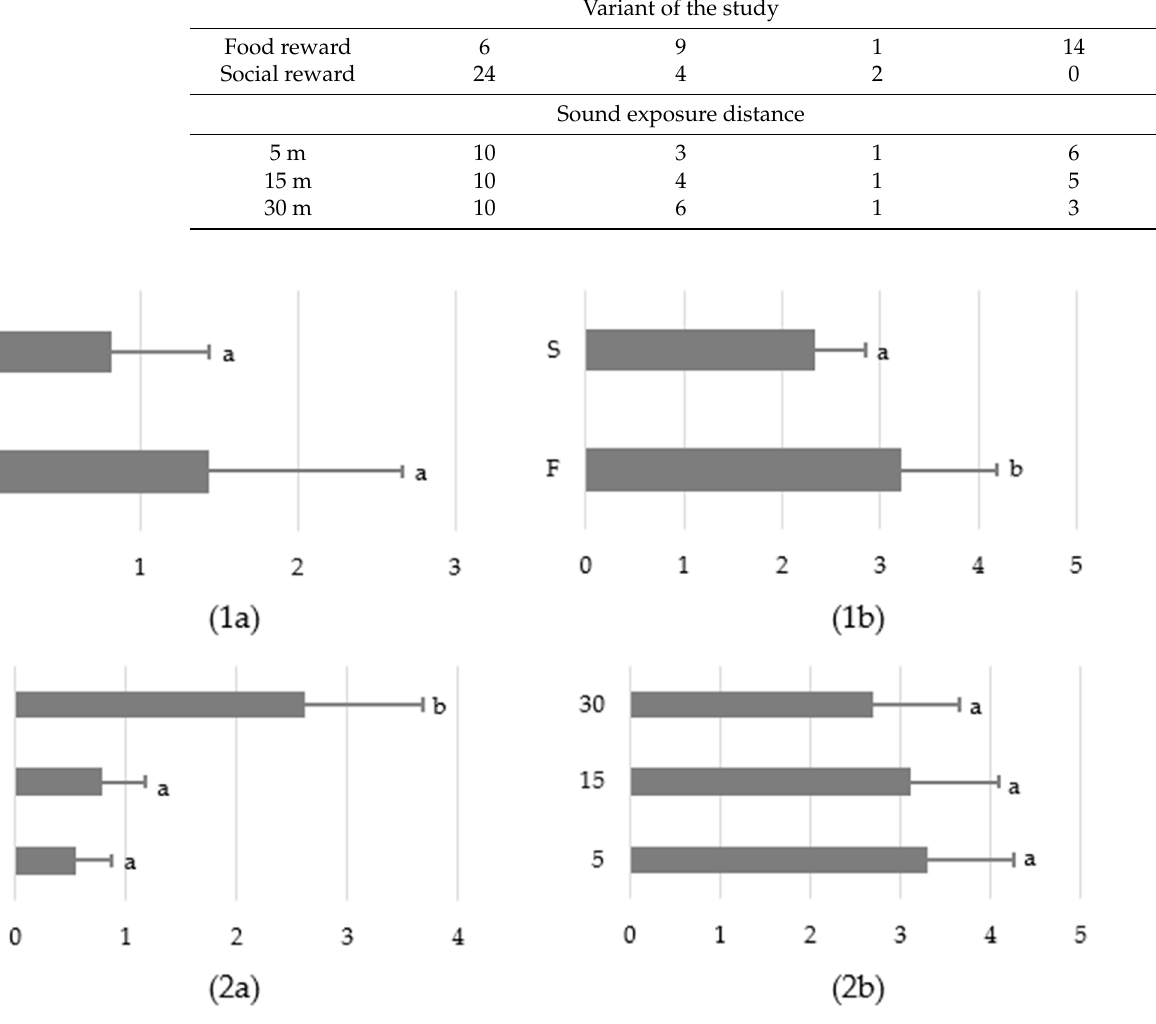
Figure 2. ( 1a ). The impact of the test variant (food reward—F/social reward—S) on latency time to respond to the sound [s]. ( 1b ). The impact of the test variant on the effect of the sound barrier assessed on a 4 ‐ point scale. ( 2a ). The impact of the sound exposure distance (30, 15 or 5 m) on latency time to respond to the sound [s]. ( 2b ). The impact of the sound exposure distance on the effect of the sound barrier assessed on a 4 ‐ point scale. Means marked with different letters differ significantly at p < 0.05. Table 4. Number of the horses that ignored, stopped, went or ran away after the sound application regarding the variant of the study and the sound exposure distance.